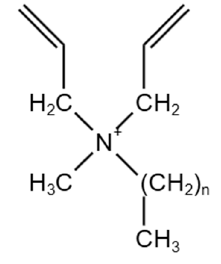
Figure 5. DS-n molecular structure.